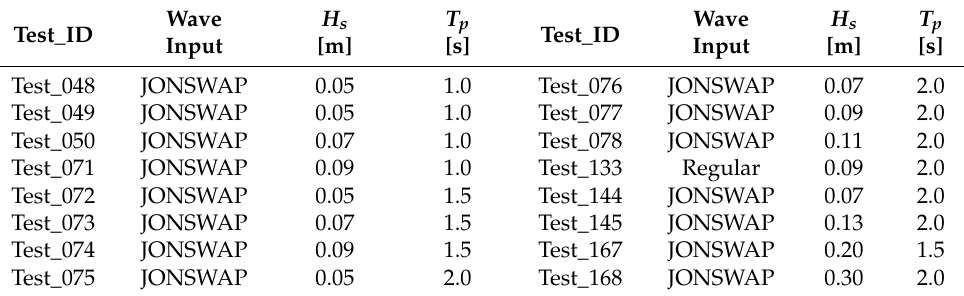
Table 5. Overview of the performed excitation